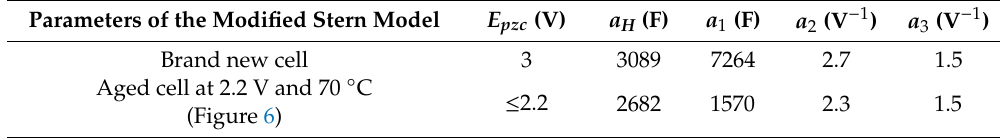
Table 2. Comparison of the C(V) model parameters before and after aging at 2.2 V and 70 °C during 20 months.